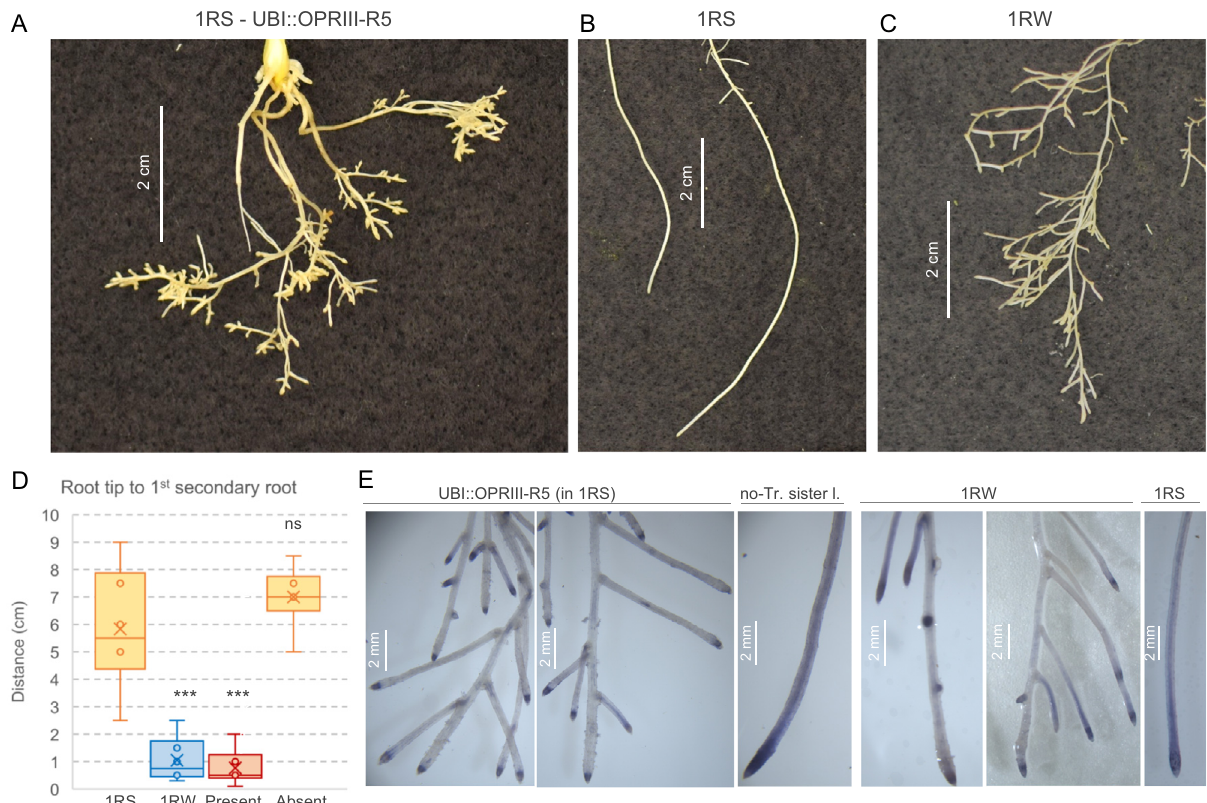
Fig.3|Effectofover-expressionof OPRIII genesonrootarchitectures.A – C Last 5cm of the seminal roots showing different branching patterns. A UBI::OPRIII-R5, ( B )1RSand( C )1RW. D Distancebetweentheroottipandthe fi rstsecondaryrootin 1RS,1RS RW andUBI::OPRIII-R5sisterlineswithandwithoutthetransgene( n =6).The boxes show the range from fi rst to third quartiles divided by the median. The whiskersspanfromtheminimumtothemaximumobservationandcirclesindicate individualdata. P valuesbasedontwo-sidedDunnetttestsrelativeto1RScontrol:ns